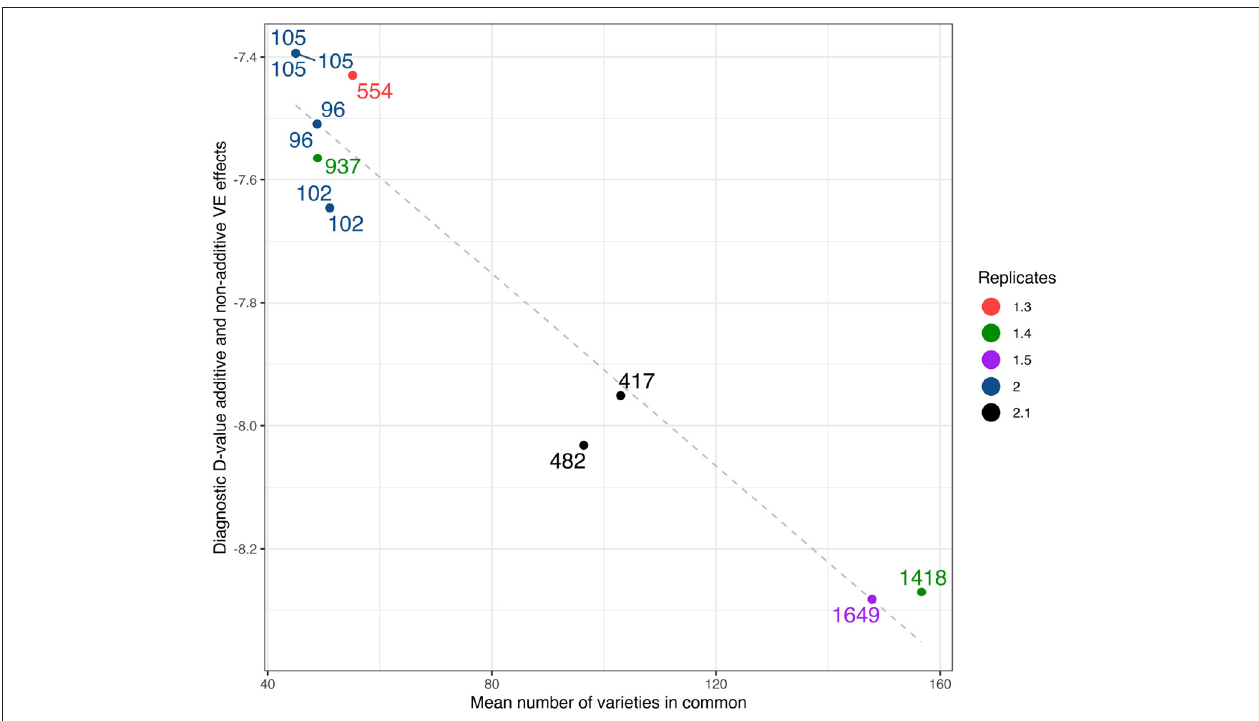
FIGURE 3 | Durum example: Diagnostic D j (A+I)-values based on LMM with additive and non-additive VE effects plotted against mean number of varieties in common. Labels show the total number of varieties, colors as represented in legend show the mean number of